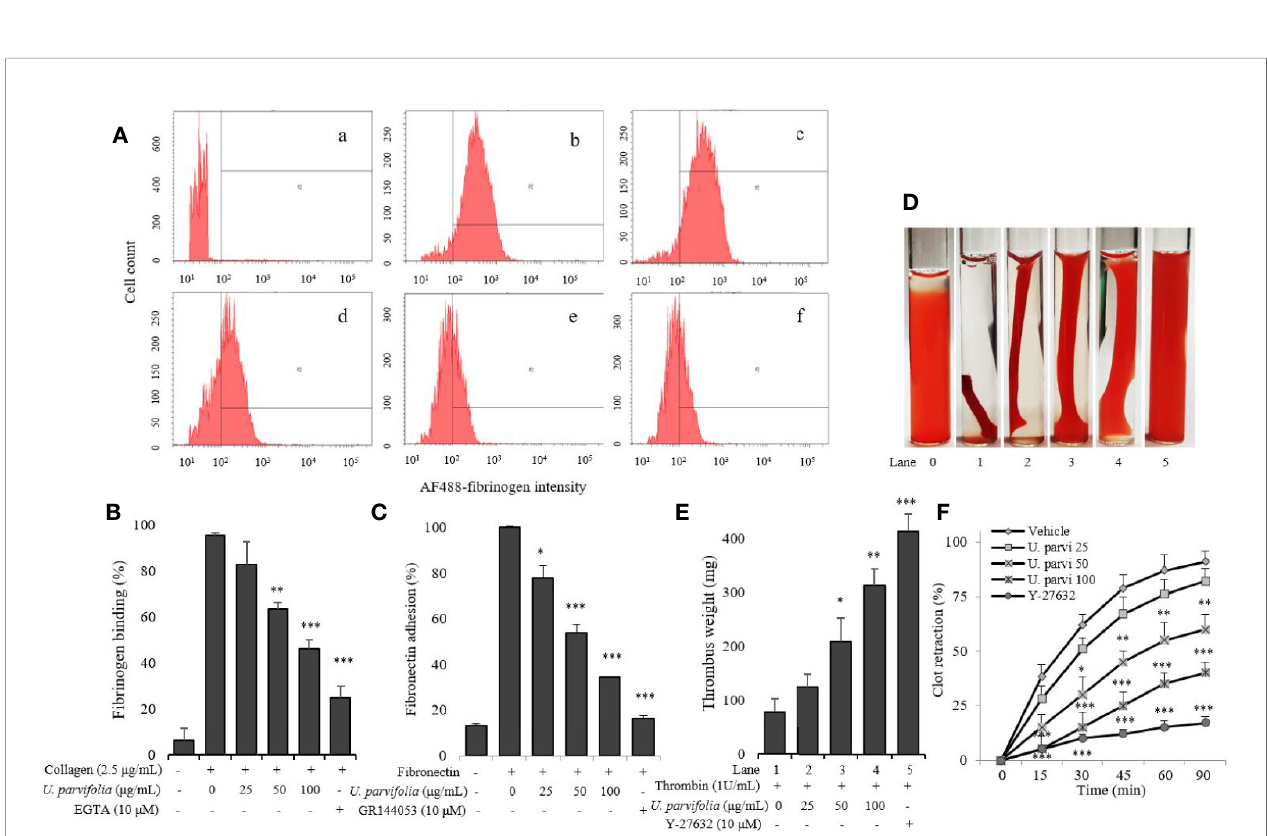
FIGURE 3 | U. parvifolia inhibits integrin a IIb b 3 -mediated inside-out and outside-in signaling. (A, B) Flow cytometric measurements of fi brinogen binding in platelets treated with vehicle, various U. parvifolia extract concentrations or EGTA [(a) Resting, (b) Vehicle, (c) 25 µg/ml, (d) 50 µg/ml, and (e) 100 µg/ml, (f) 10 µM EGTA)] and stimulated with collagen (b-f). (C) Results of fi bronectin adhesion assay, which was performed using an assay kit according to the manufacturer's protocol and by following the procedure described in the methods section. (D) In vitro effect of U. parvifolia extract on clot retraction for 2 h at room temperature after thrombin addition and photographed with 15 min intervals. Representative images of clot retraction at 90 min after thrombin addition in the presence and absence of U. parvifolia extract. Y-27632 (ROCK inhibitor) was used as a control. (F) Kinetics of clot retraction were measured by Image-J software and clot surface areas were plotted as a percentage of retraction. Bar graphs summarizing the inhibitory effect of U. parvifolia extract on fi brinogen binding to integrin a IIb b 3 (B) , fi bronectin adhesion (C) , clot retraction (E) , and kinetics of clot retraction (F) . Results are shown as mean ± SD values from at least four independent experiments. * p < 0.05, ** p < 0.01, and *** p < 0.001 versus